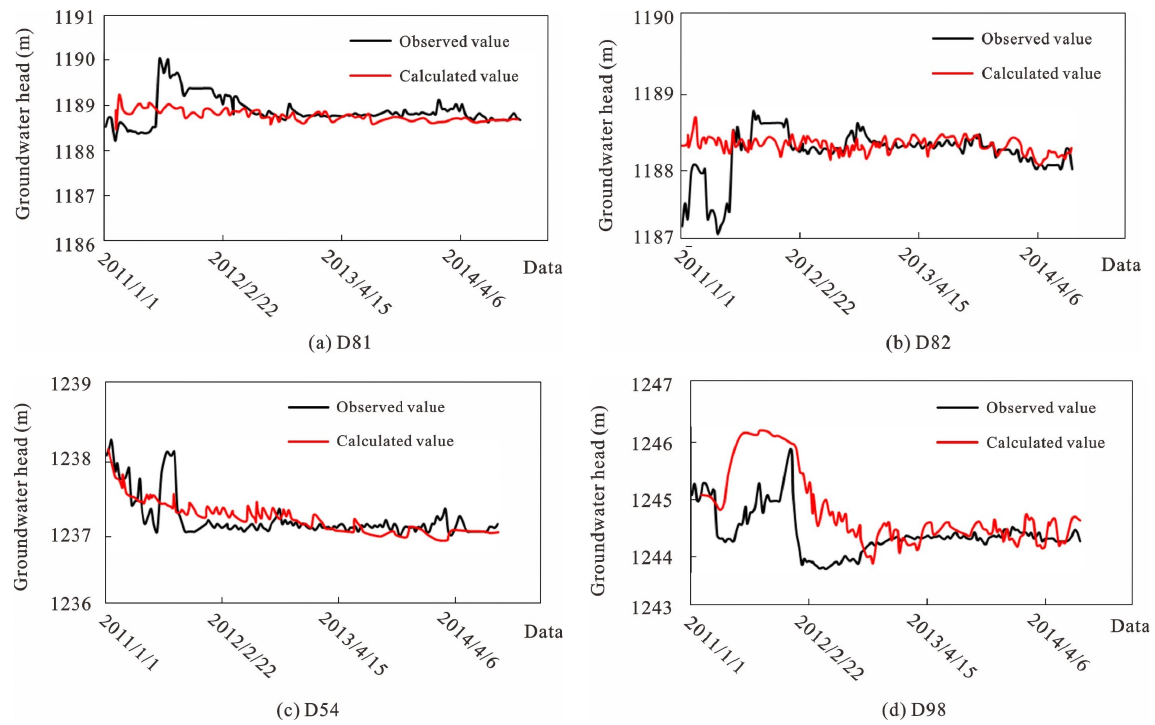
Figure 6. Comparison curves between observed and calculated groundwater levels: ( a ) D81, ( b ) D82, ( c ) D54, ( d ) D98. ( c ) D54, ( d )